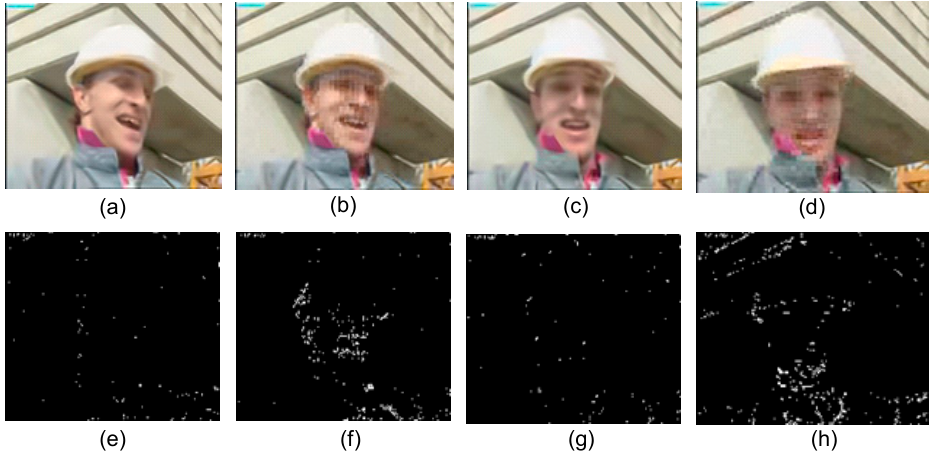
Figure 5. Inconsistent image quality introduced by DISCOVER DVC for the Foreman sequence: ( a ) 14 th decoded key frame, ( b ) 14 th decoded WZ frame, ( c ) 15 th decoded key frame, ( d ) 15 th decoded WZ frame. The bottom row shows the distortion images between the decoded frames and the original frames, respectively: ( e ) 14 th key frame, ( f ) 14 th WZ frame, ( g ) 15 th key frame, and and ( h ) 15 th WZ frame.